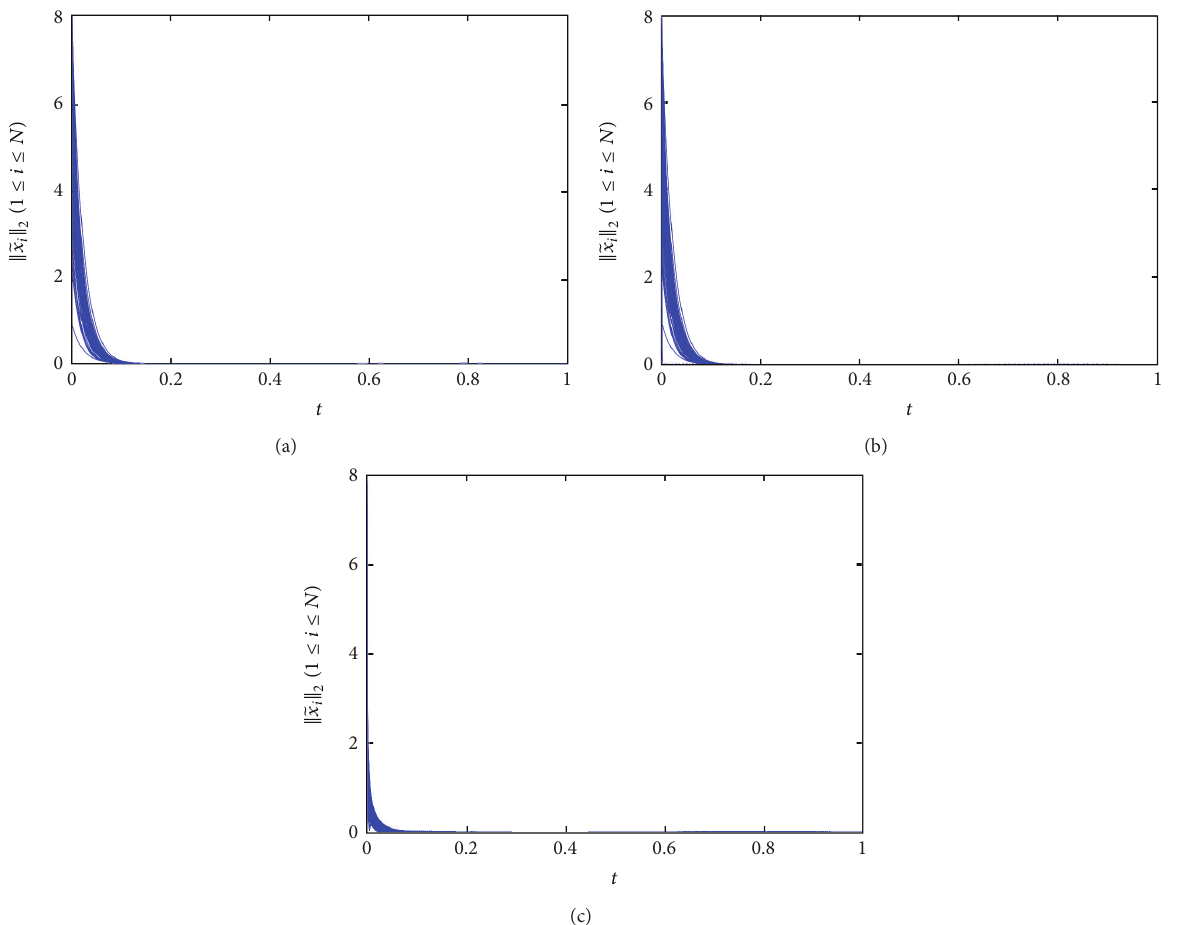
Figure 1: Synchronization errors ‖̃ x 𝑖 ‖ 2 (1 ≤ 𝑖 ≤ 50) for globally coupled network (GCN) with 𝑐 = 1 , H = I (a); ‖̃ x 𝑖 ‖ 2 (1 ≤ 𝑖 ≤ 50) for star network (SN) with 𝑐 = 50 , H = I (b); ‖̃ x 𝑖 ‖ 2 (1 ≤ 𝑖 ≤ 50) for loop network (LN) with 𝑐 = 3040 , H = I